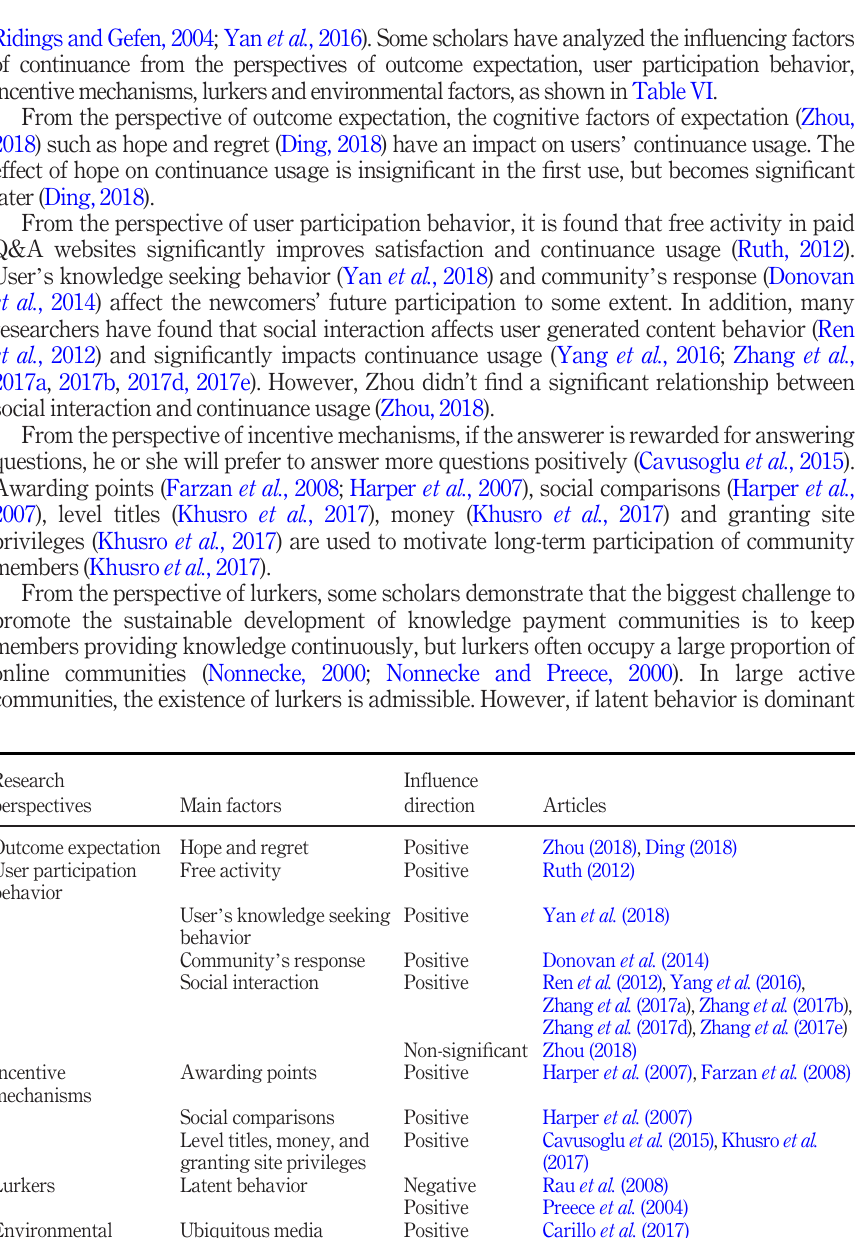
Table VI. In fl uencing factors